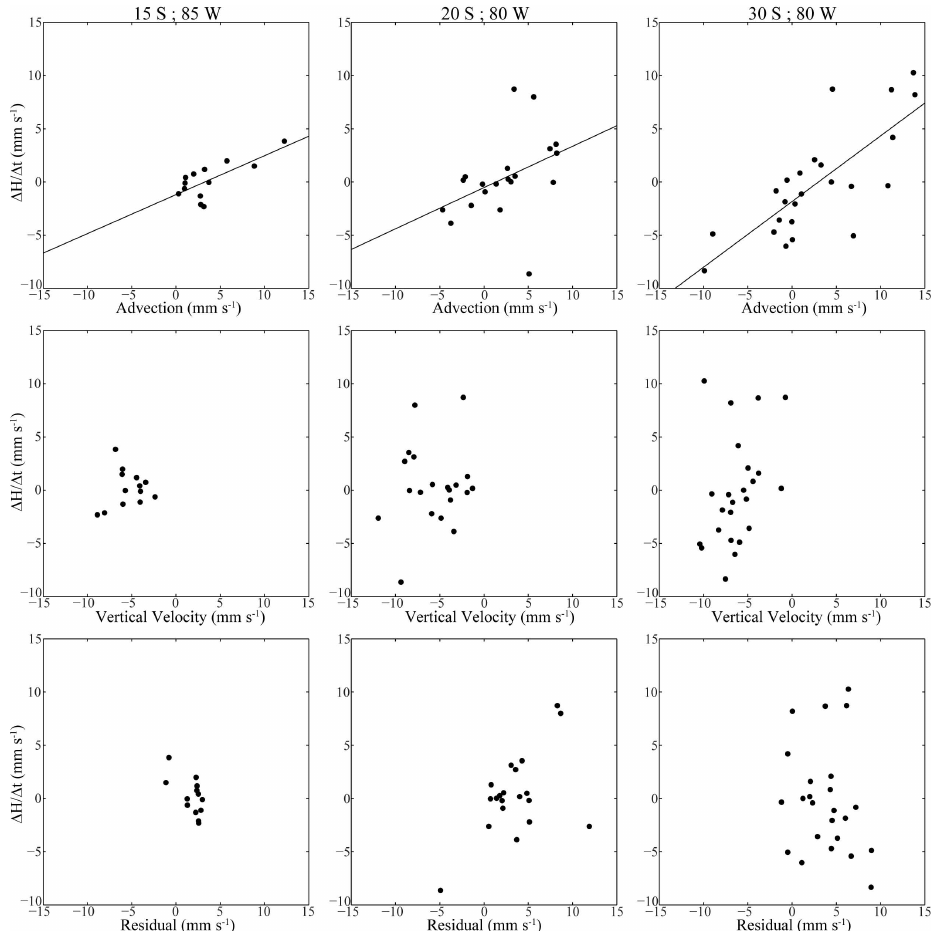
Fig. 9. Relation between changes in depth and the advective (top), vertical velocity (center) and residual (bottom) terms. Locations are 15 ◦ S, 85 ◦ W (left), 20 ◦ S, 80 ◦ W (center), and 30 ◦ S, 80 ◦ W (right). Lines on top are from a standard linear regression. Each dot represents the average value in the time period indicated in Fig.